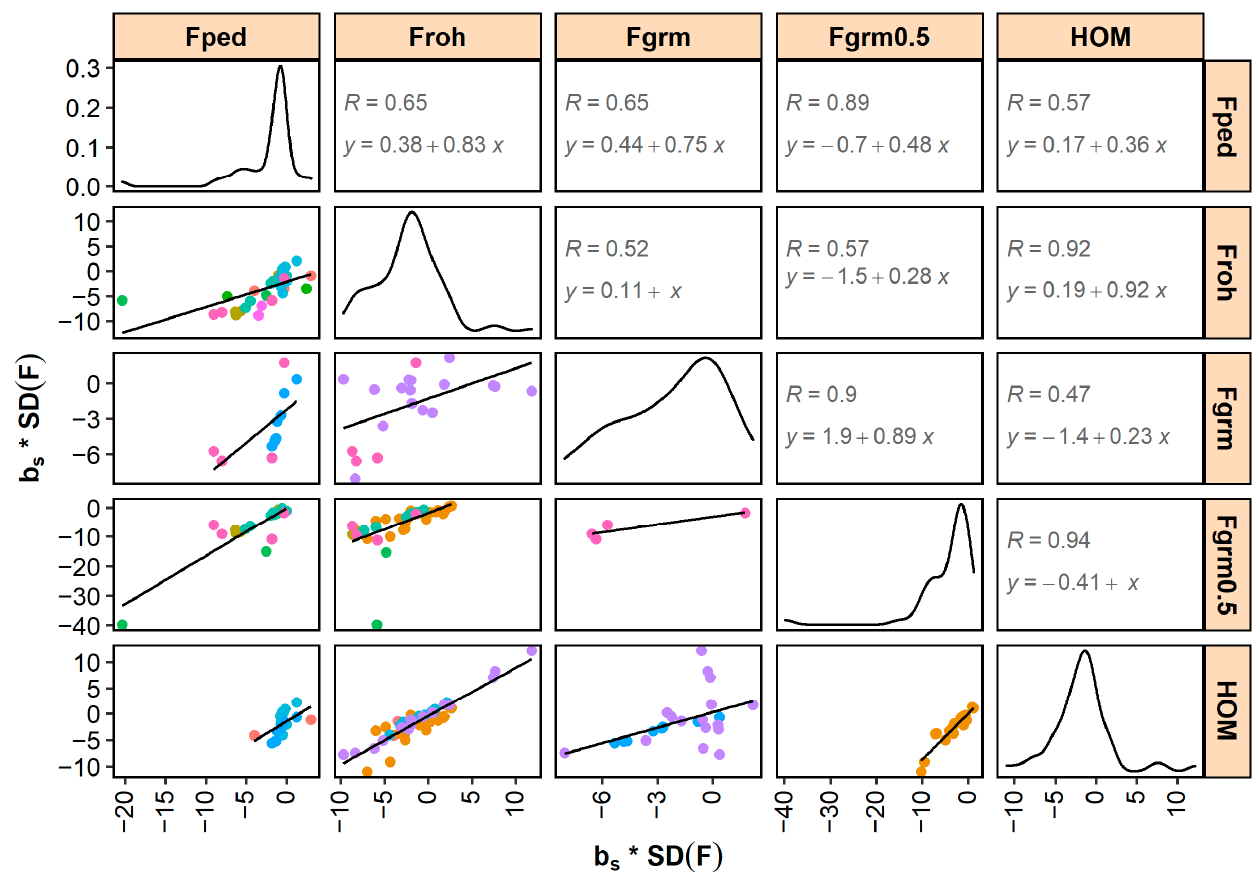
Figure 4. Relationship between inbreeding depression estimates expressed as percentage of a trait’s standard deviation per 1 standard deviation increase in inbreeding ( b s * SD(F)) across different measures of inbreeding. The data points (colored per study) and linear trendline are shown (lower triangle), as well as the density curve for each inbreeding measure (diagonal) and the correlation and regression equation (upper triangle). Note that slopes of the linear trendline differ from 1, which is also expected when correlations between inbreeding measures themselves are not equal to 1. F PED = pedigree inbreeding; F ROH = inbreeding based on runs of homozygosity; F GRM = inbreeding from genomic relationship matrix (studies in pink and purple used VanRaden’s method 2, and light blue used Yang’s method); F GRM 0.5 = inbreeding from genomic relationship matrix with allele frequencies fixed to 0.5; 𝐻𝑂𝑀 = percentage of homozygous SNPs.